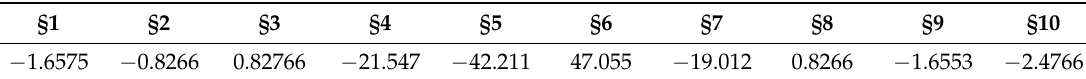
Figure 9. The experimental setup. Table 3. The strain data measured by FBG (× 10 (cid:2879)(cid:2874) ) .